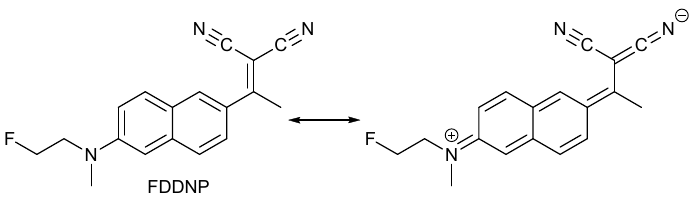
Figure 1. Limiting resonance forms showing electron delocalization in FDDNP.